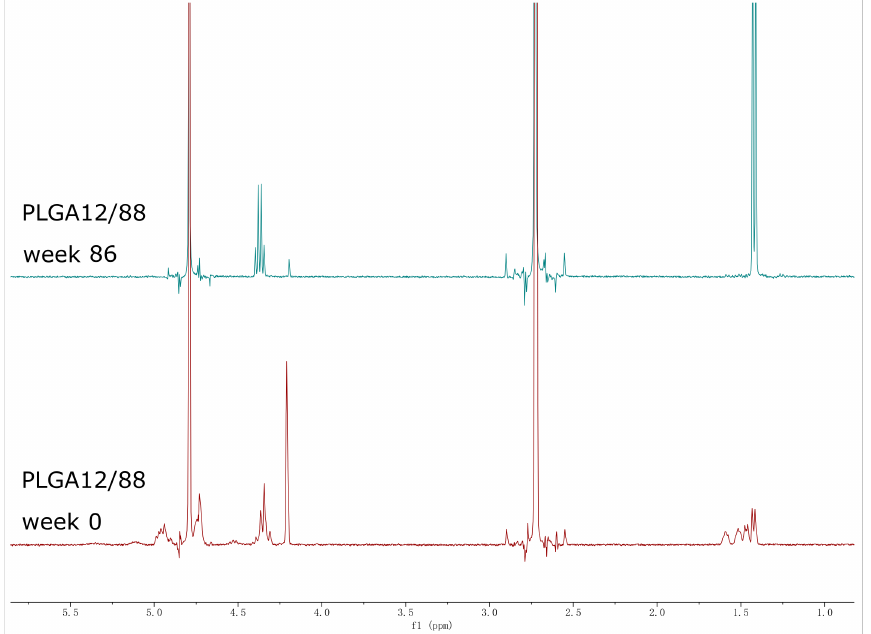
Figure A1. 1 H NMR spectra of PLGA 12/88 hydrolysis in D 2 O with 2.0 mg dimethyl sulfoxide as internal standard after 0 and 86